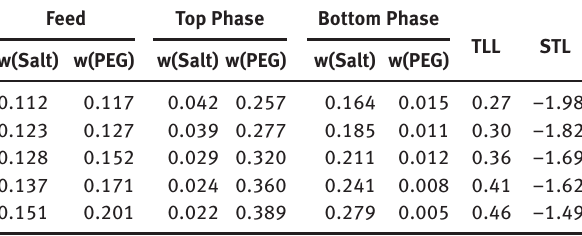
Table 1: Mass fraction of feed, top and bottom phases for PEG 10000 + Sodium Citrate + H O at 298.15 K and 84 kPa, and the 2 calculated TLL and STL.